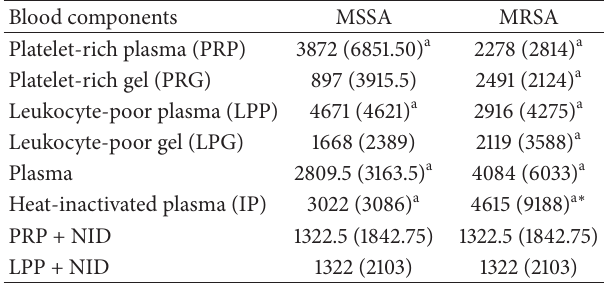
Table 3: PF-4 (pg/mL) concentration in every blood component cultured with either MSSA or MRSA at 24